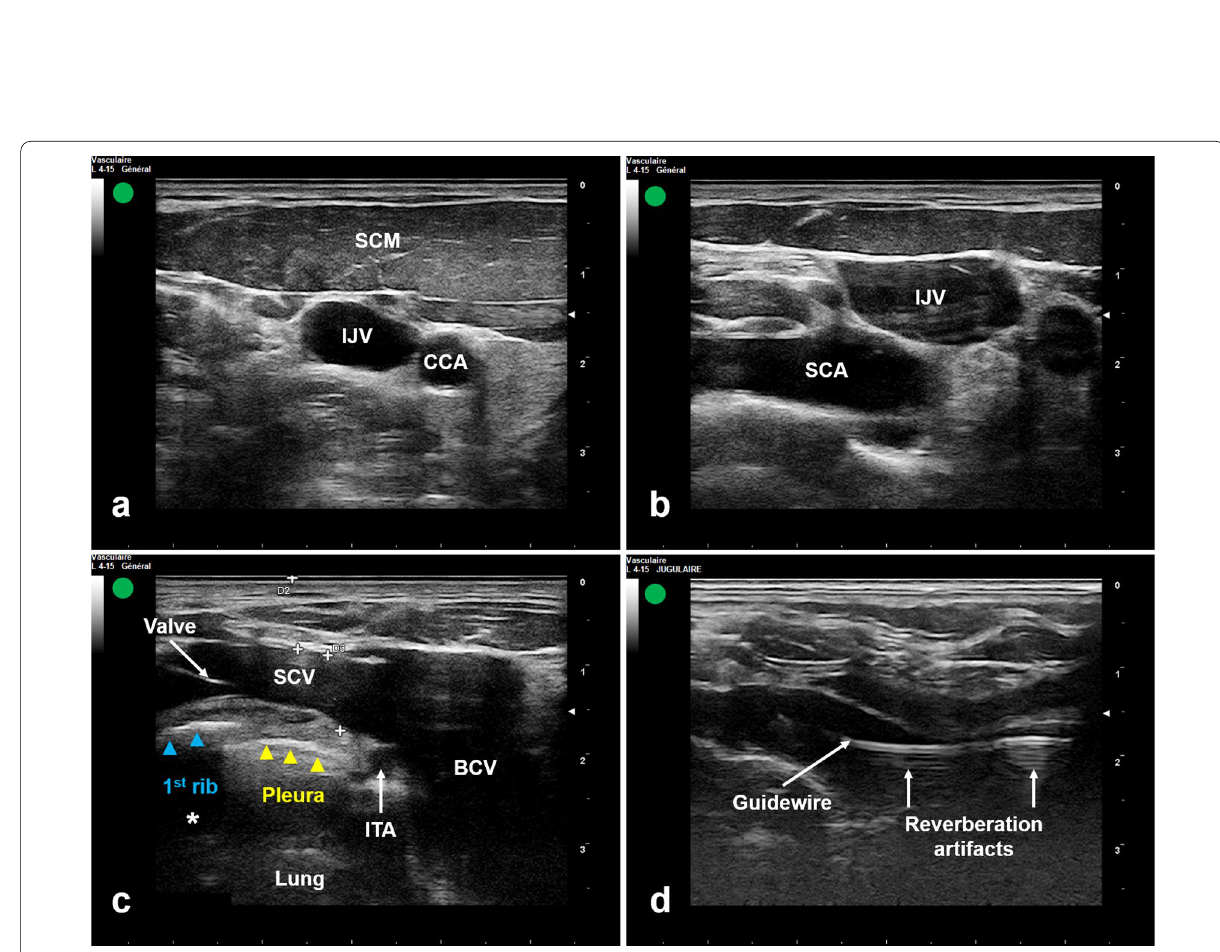
Fig. 2 Ultrasound-guided subclavian vein catheterization using the long-axis view of the vein via the supraclavicular approach in combination with in-plane needle approach. a Ultrasound short-axis view of IJV. b Ultrasound identification of IJV and SCA in the supraclavicular fossa. c Ultrasound long-axis view of SCV and BCV. d Ultrasound visualization of the guidewire in the SCV. SCV subclavian vein, SCA subclavian artery, BCV brachiocephalic vein, ITA internal thoracic artery, Asterisk acoustic shadow of the 1st